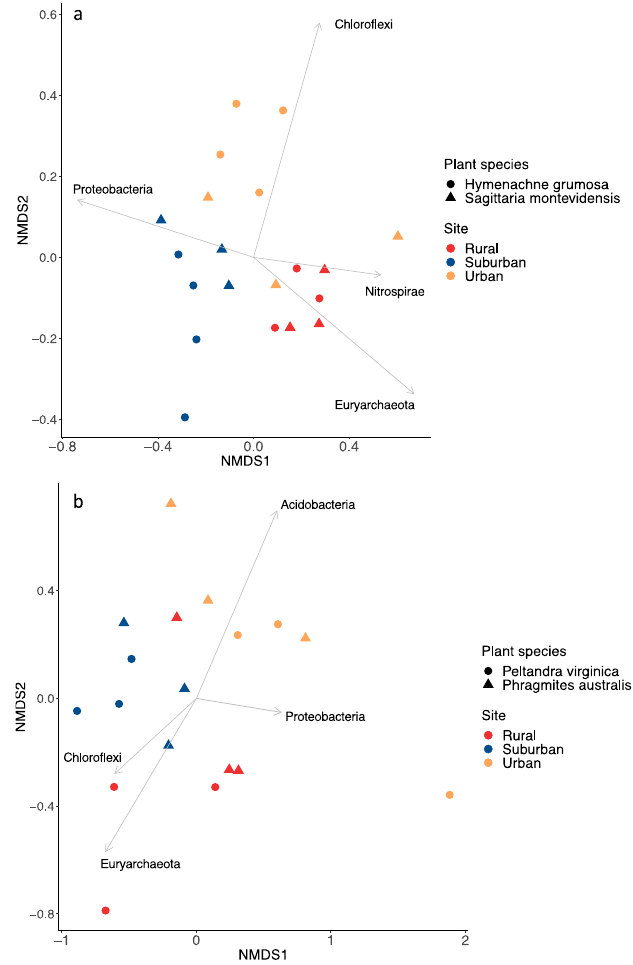
Figure 2. Non-metric multidimensional scaling ordination (NMDS) constructed using a Bray-Curtis dissimilarity matrix. Each point represents a sample with colors corresponding to sites, and shapes to plant species. The final stress values were 0.193 and 0.124 for the Buenos Aires ( a ) and Washington D.C. ( b ) ordinations, respectively. Vectors show the correlation of the most abundant phyla to community composition at the different sites.